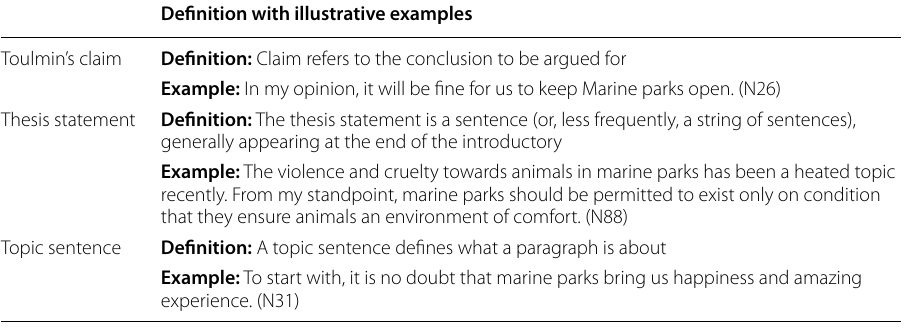
Table 1 Definitions and examples of Toulmin’s claim, thesis statement and topic